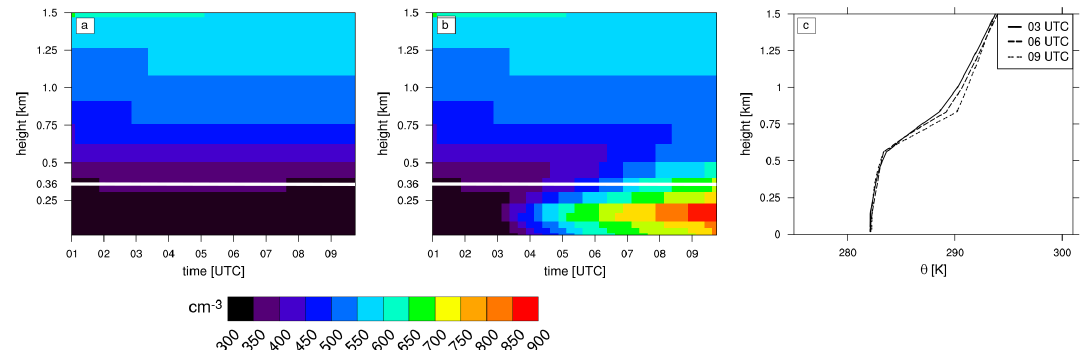
Figure 5. (a–b) Mixed aerosol number concentration [cm − 3 ] averaged at each level over the ship track domain at a 15min interval for (a) clean and (b) ship10 . The mean cloud base height is shown in white. (c) Potential temperature ( θ ) profiles at 03:00, 06:00 and 09:00UTC at the ship track domain centre